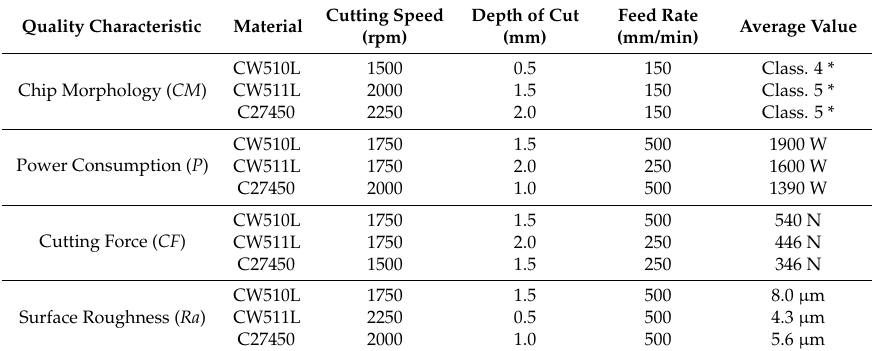
Table 2. The “worst” combinations of cutting parameters for the quality characteristics (chip morphology, power consumption, cutting force, surface roughness-Ra) of studied lead-free brass alloys in “as received” condition [13,18].